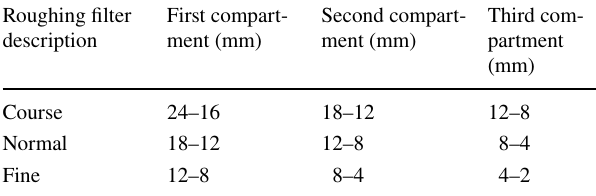
Table 2 Experimental conditions for the limestone used in the pre- sent study